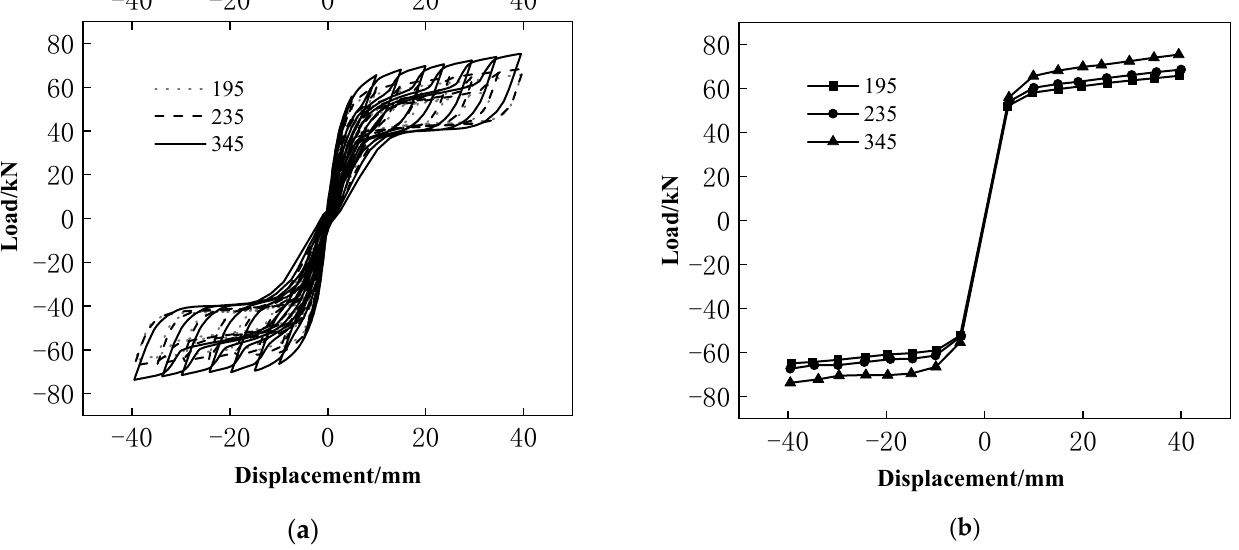
Figure 17. Hysteretic curve and skeleton curve under different energy dissipation ring strength. ( a ) Hysteretic curve. ( b ) Skeleton curve.